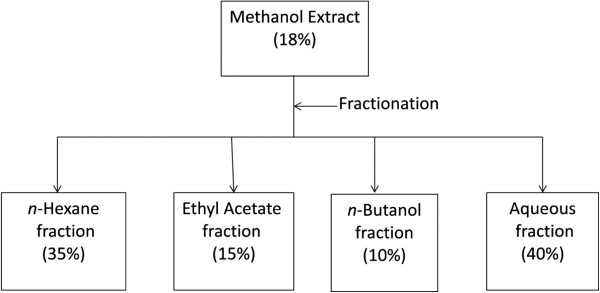
Flow sheet of extraction and fractionation of
S. cordata
with percent yield.